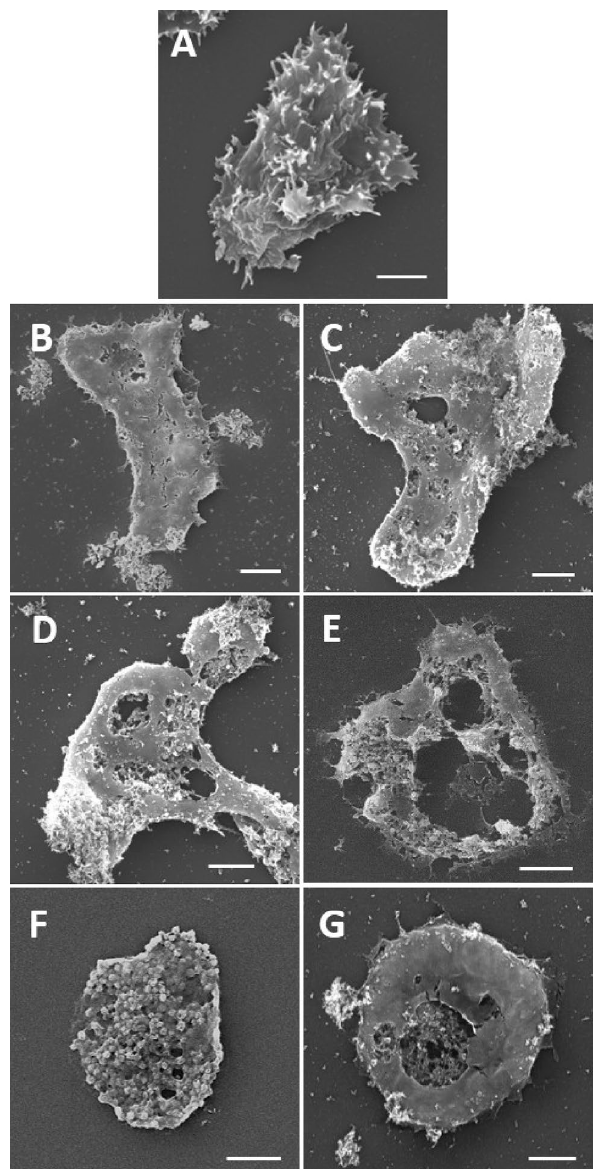
2 mg/L of CLX after 24 h, ( E ) 2 mg/L of CLX after 48 h, ( F ) 8 mg/L of ArCO 2 G2(SNMe 3 I) 4 ( 2 ) and 1 mg/L of CLX after 24 h, ( G ) 8 mg/L of ArCO 2 G2(SNMe 3 I) 4 ( 2 ) and 0.5 mg/L of CLX after 48 h. Scale bars = 5